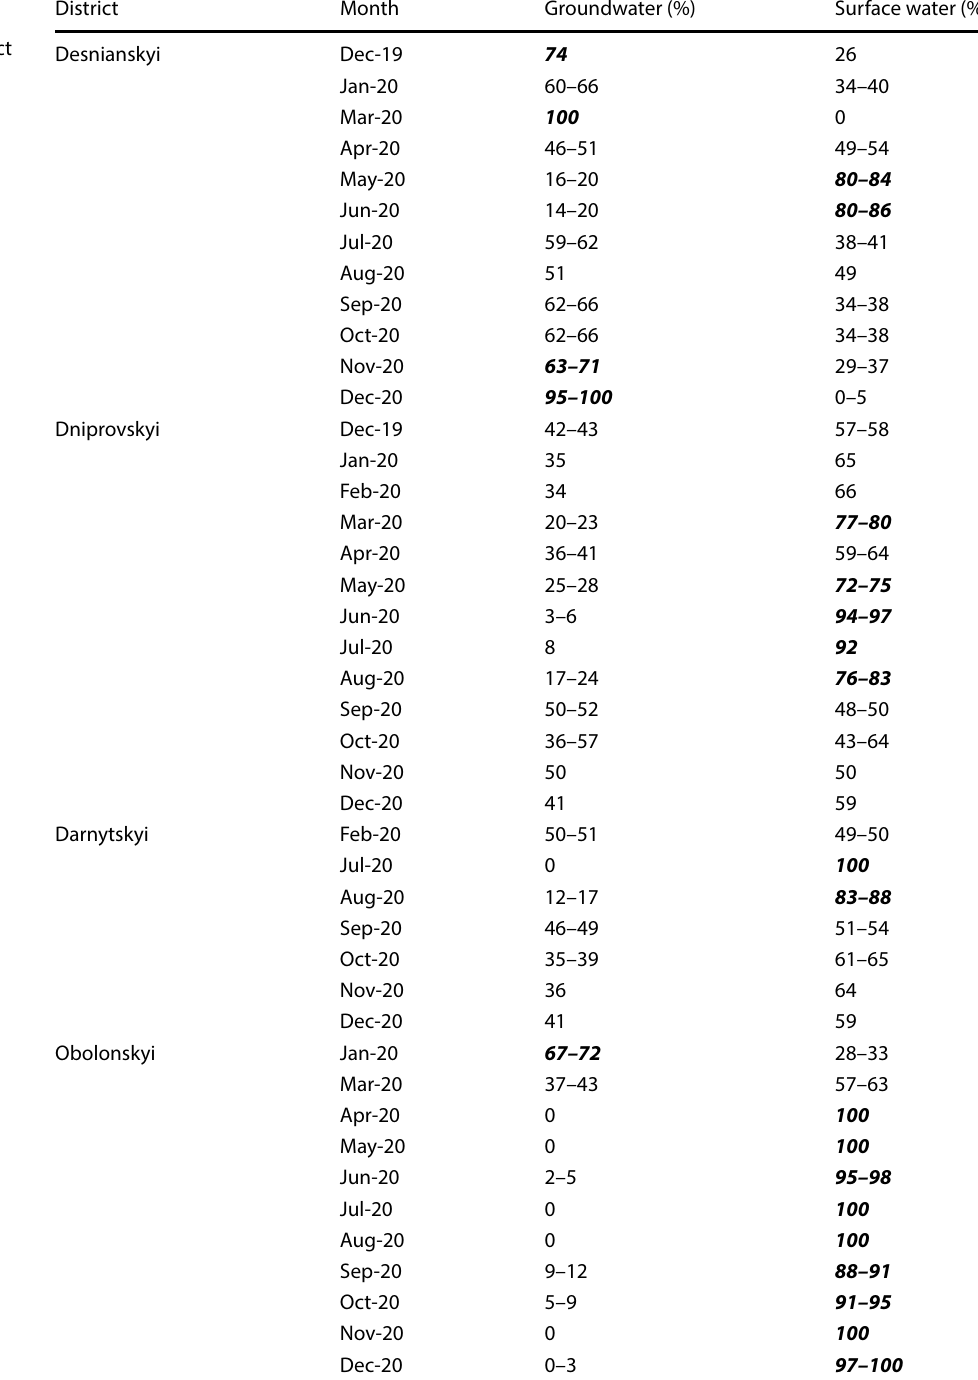
Table 1 Percentage groundwater and surface water contribution to district tap water by